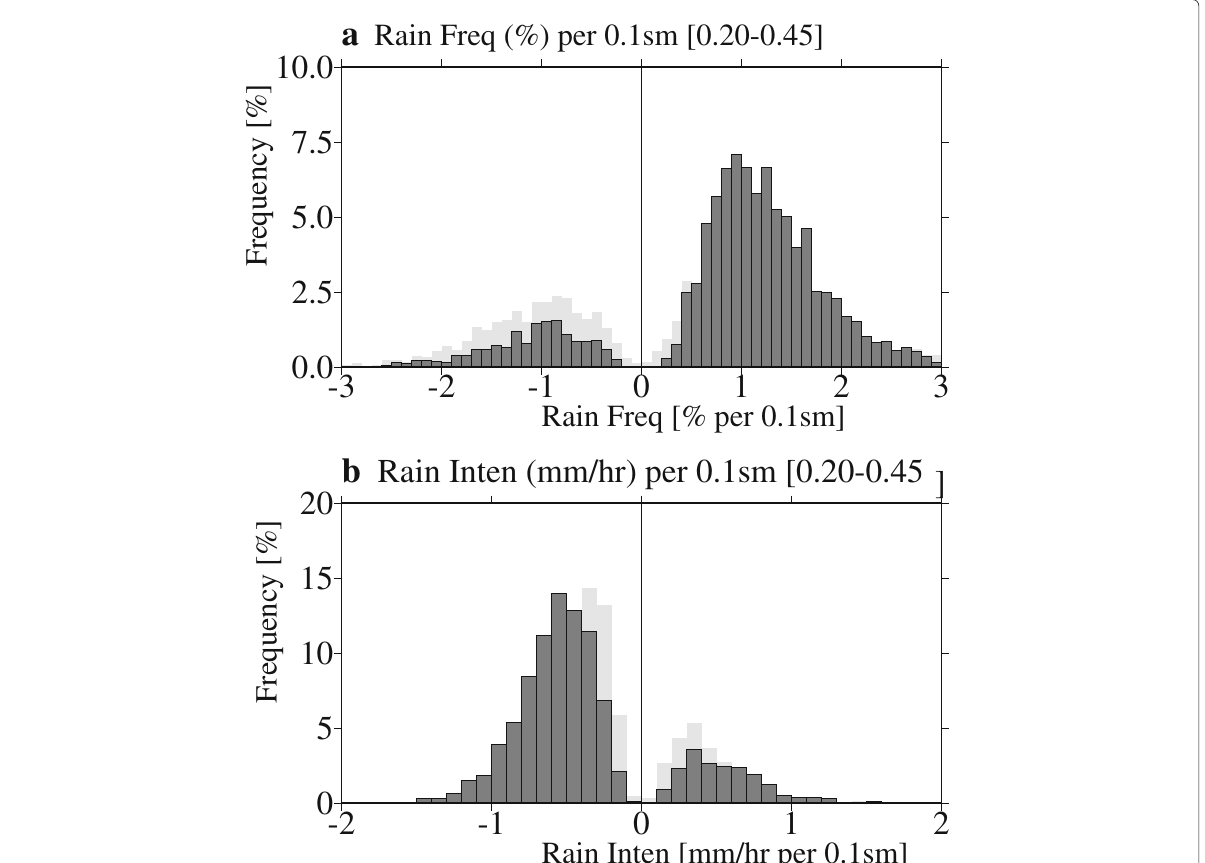
Fig. 5 Histogram of PSMsens (slope values) of a rainfall frequency and b rainfall intensity over the land regions. The dark shading represents the histogram for lowland regions (elevation is below 300 m). The light shading denotes the histogram for all land regions. The horizontal axes in a and b are mm h − 1 per 0.1 increase in soil moisture and % per 0.1 increase in soil moisture, respectively. The vertical axes are the frequency of each bin, expressed as a percentage